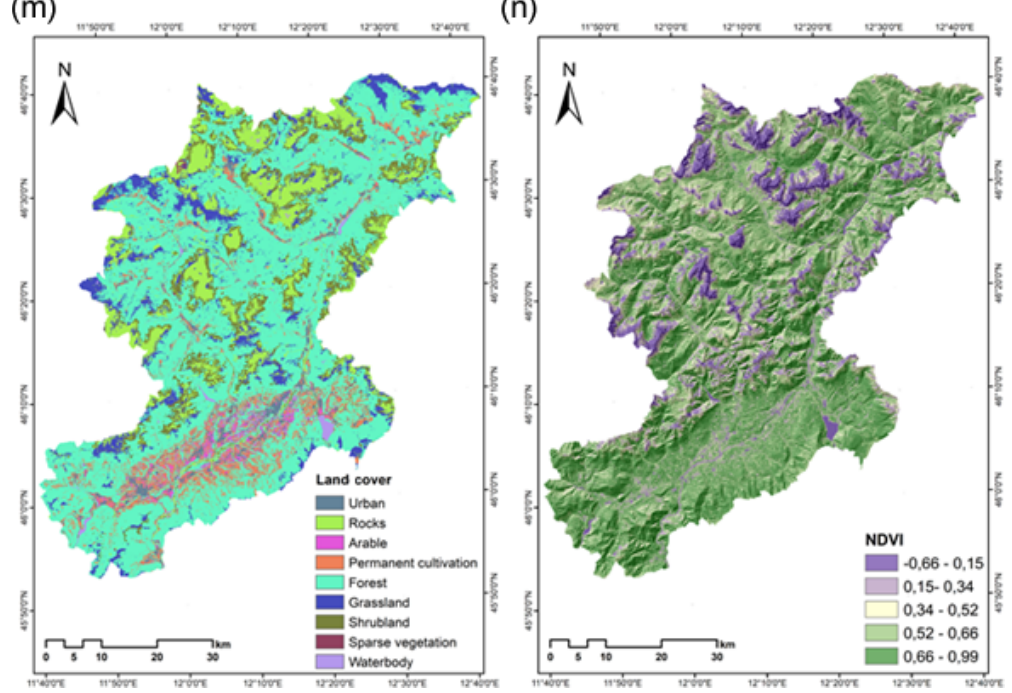
Figure 2. Maps of the conditioning factors used in this study: (a) elevation, (b) slope, (c) aspect, (d) topographic wetness index, (e) to- pographic position index, (f) topographic roughness index, (g) profile curvature, (h) plane curvature, (i) distance to drainage networks, (j) rainfall monthly average (1994–2020; mm), (k) lithology, (l) distance to road network, (m) land cover, and (n)